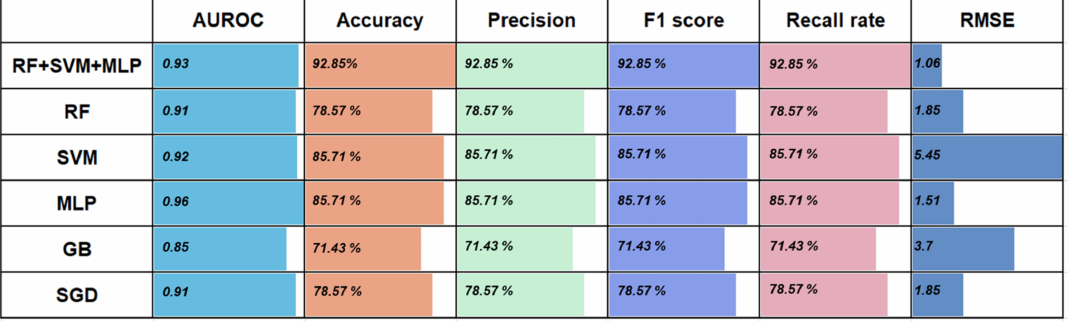
Figure 6. The performance of the best-performing stacking ensemble model and five base